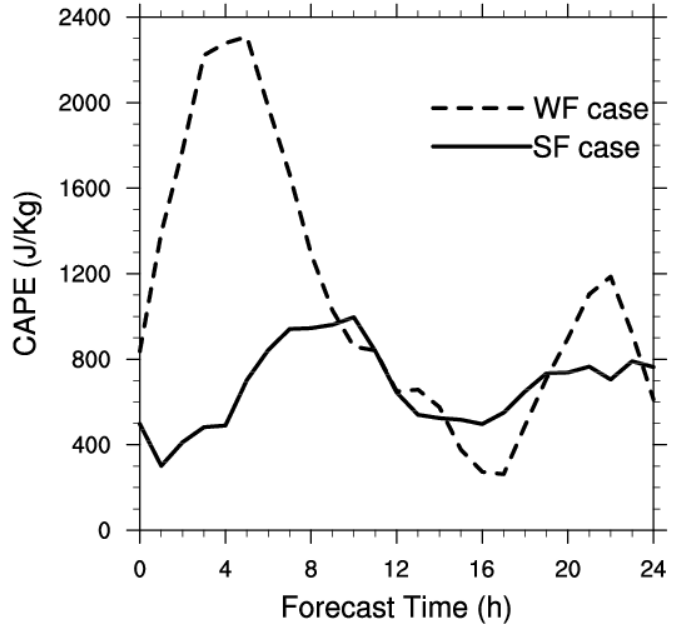
Figure 5. The time series of the precipitation area-average (>1.0 mm/h) convective available potential energy (CAPE) in two cases (black solid line: SF case, black dotted line: WF case).